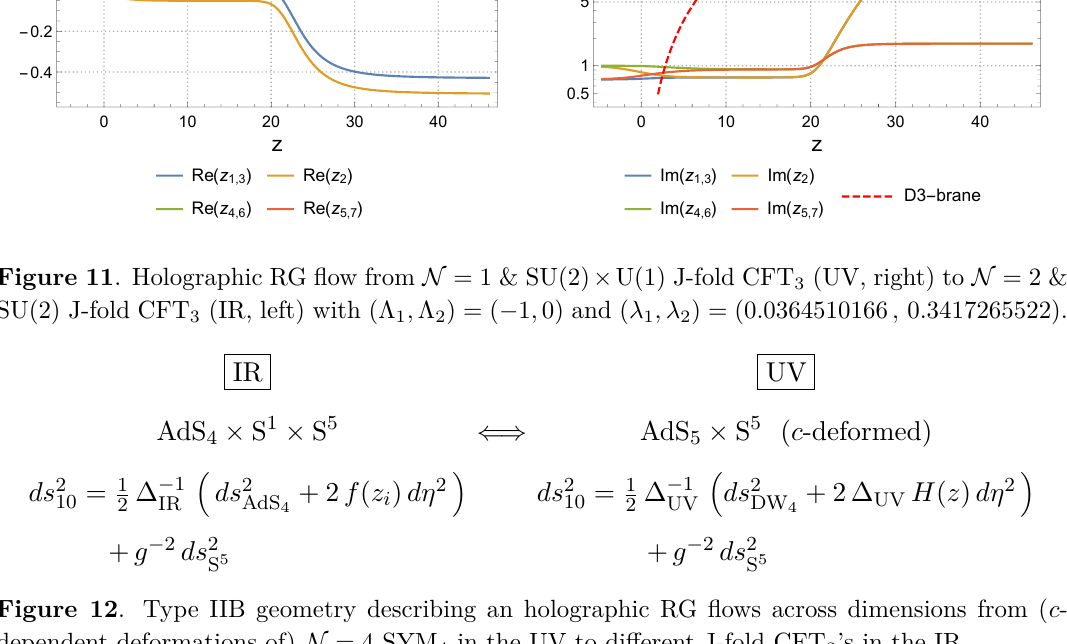
in the UV to different J-fold CFT 4